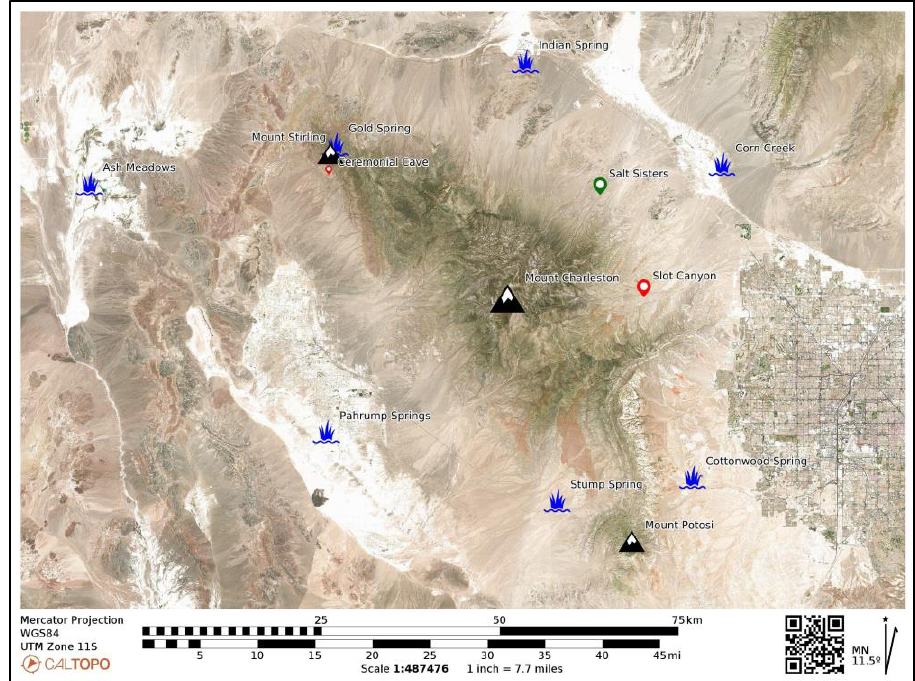
Figure 24. Map of Spring Mountains with Pilgrimage Support Communities and Trail Destinations Marked [66].